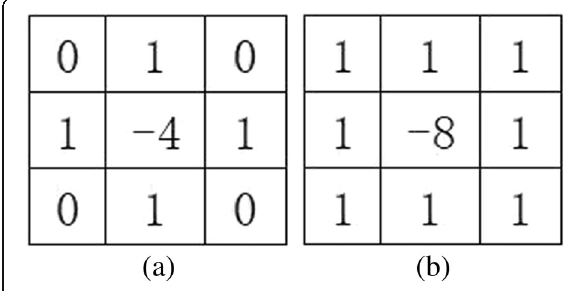
Fig. 1 Two Laplacian filter masks. ( a ) is a discrete Laplacian mask corresponding to Equation 7, and ( b ) is an extended mask of ( a